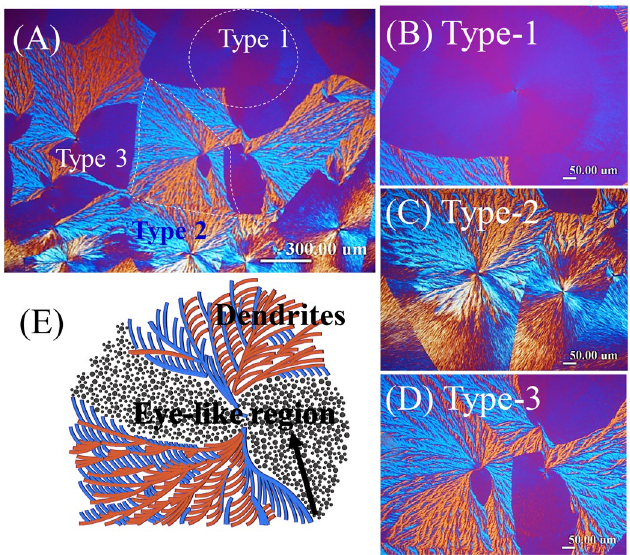
spherulites: ( B ) Type-1 positive-type low-birefringence, ( C ) Type-2 negative-type fully dendritic, and ( D ) Type-3 sector-face high-birefringence spherulites, and ( E ) detailed scheme for sector-face PLLA